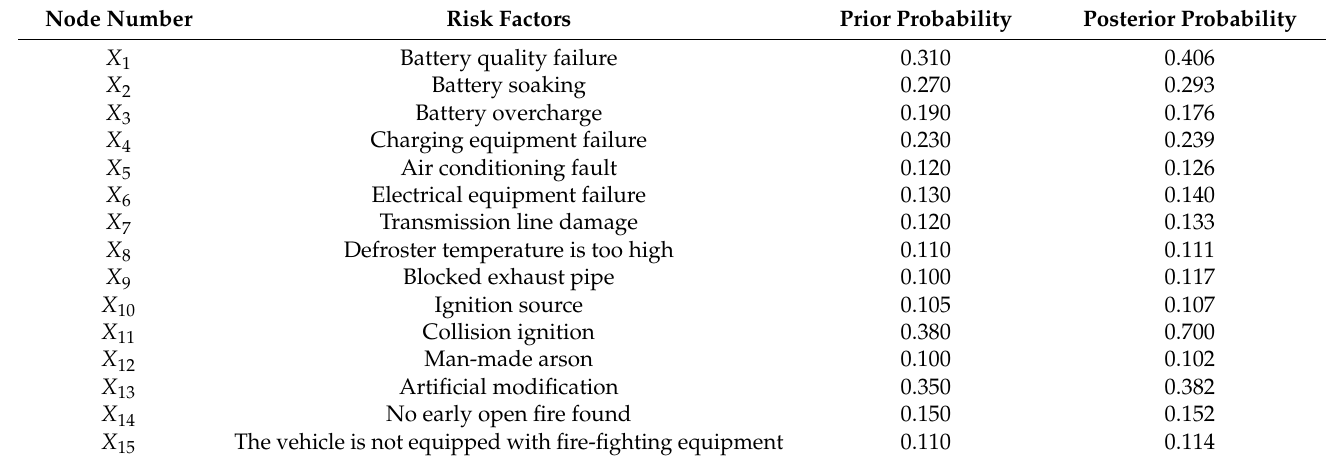
Table 5. Prior probability and posterior probability of each risk